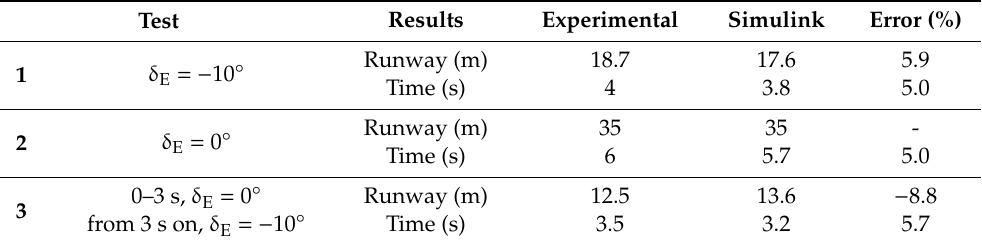
Table 5. Take-o ff